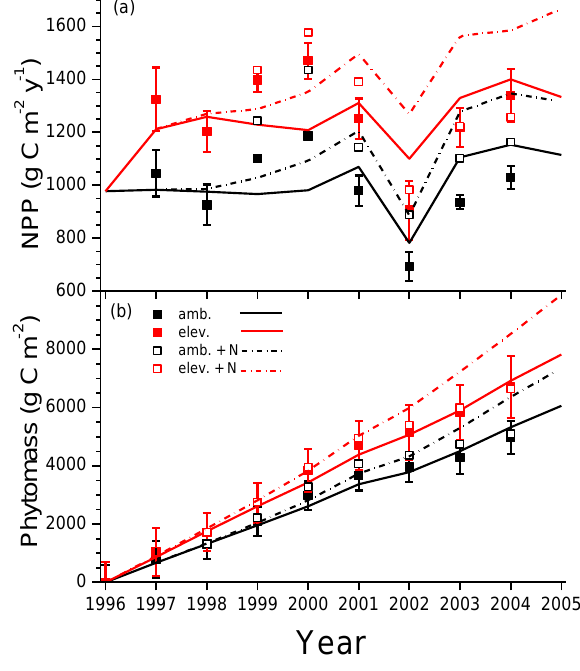
Fig. 2. (a) Annual net primary productivity (NPP) and (b) gain Fig. 2. in total phytomass measured (symbols) and modelled (lines) from 1997 to 2004 under ambient ( ∼ 371µmolmol − 1 ) vs. elevated ( ∼ 571µmolmol − 1 ) atmospheric CO 2 concentration ( C a ) with or without N fertilizer at the Duke FACE experiment. Measured data from McCarthy et al. (2010), with error bars representing stan- dard errors from replicated measurements ( n = 4). Root exudation (Grant, 1993) was excluded from modelled NPP to simulate bio- metric